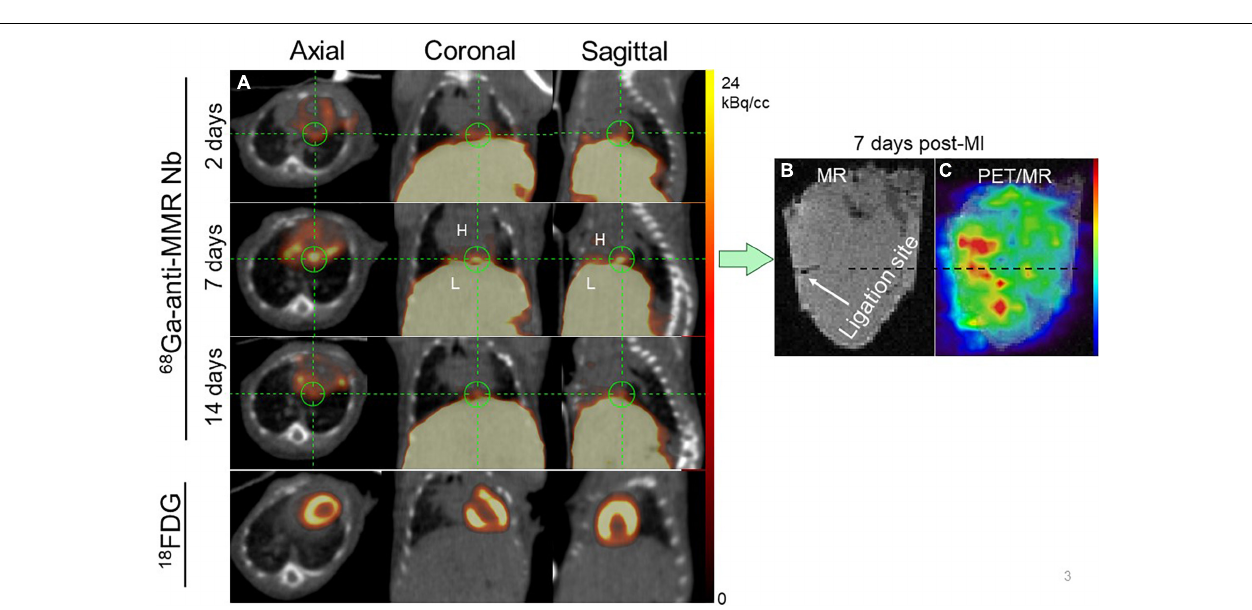
FIGURE 3 | Representative in vivo imaging of 68 Ga-NOTA-anti-MMR Nb uptake in a longitudinal study. (A) Static PET/CT matched axial, coronal and sagittal slices in the same mouse subjected to coronary ligation and scanned 1 h after injection of 68 Ga-NOTA-anti-MMR Nb (2, 7, and 14 days after MI) and 18 F-FDG (7 days after MI). In order to validate the results obtained by in vivo PET/CT imaging (in n = 6 mice) and to confirm the cardiac origin of the in vivo signal, hearts from two MI-induced mice were also scanned ex vivo . (B) MR only and (C) PET/MRI of the heart excised from a mouse, 7 days after coronary ligation, confirming augmented 68 Ga-NOTA-anti-MMR Nb uptake in the area close to the ligation site.